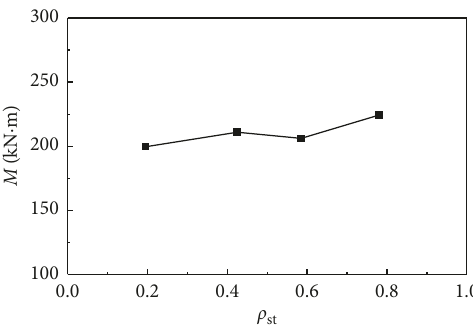
Figure 5: Relationship between M and ρ